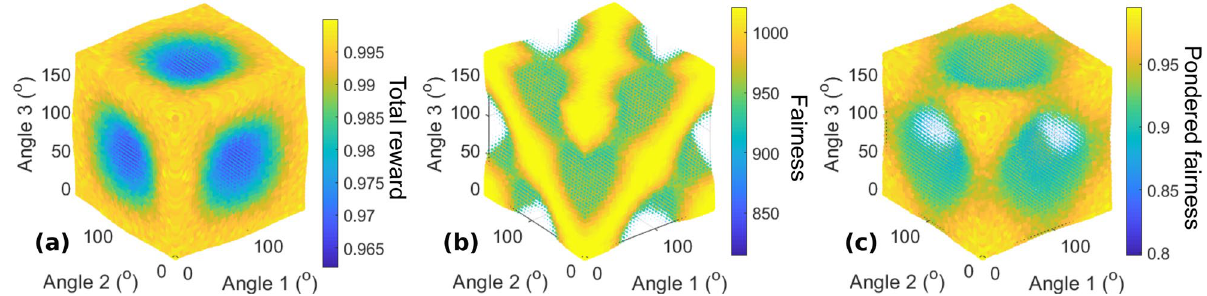
S 4 , when three users | �